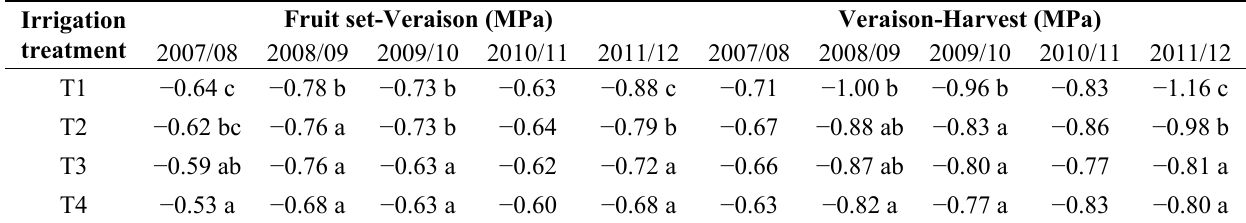
Table 3. Average stem water potential (SWP, MPa) in each experimental season. Fruit set-Veraison Irrigation treatment